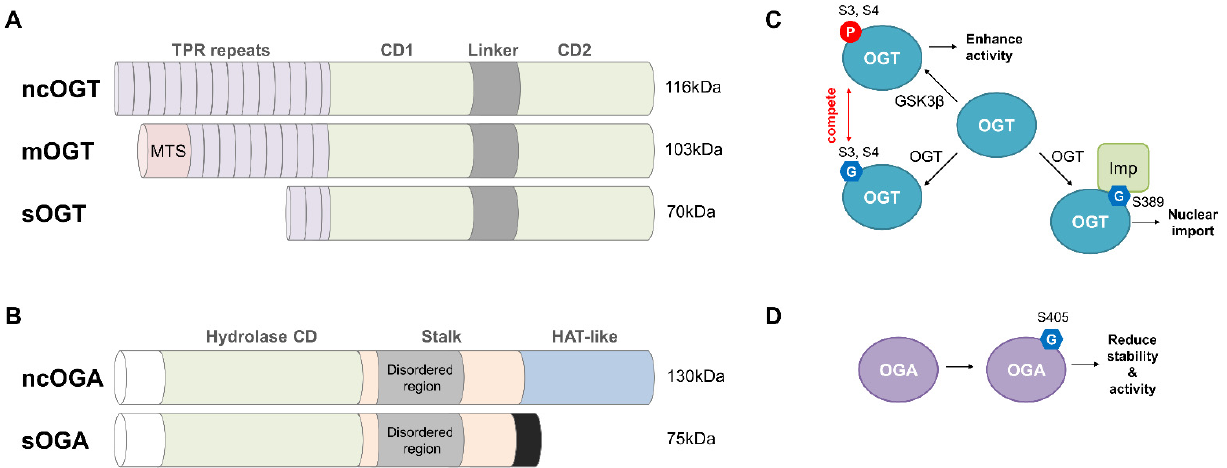
Figure 3. Exclusive enzymes directly involved in the O -GlcNAcylation cycle. ( A ) The schematic structure of hOGT isoforms. Three hOGT variants (ncOGT, mOGT, and sOGT) are derived from the OGT gene located on chromosome Xq13.1 by alternative splicing and multiple transcription start sites. These variants possess an identical catalytic domain in the C-terminal region, but they have different TPR repeats involved in substrate recognition in the N-terminal region. ncOGT (116 kDa) has 13.5 TPR repeats, mOGT (103 kDa) contains 9 TPR repeats, and sOGT possesses only 2.5 TPR repeats. Additionally, only mOGT contains a mitochondrial targeting sequence (MTS) in the N- terminal region. ( B ) The structure of human OGA (hOGA) isoforms. Two hOGA variants (ncOGA and sOGA) are produced from the MGEA5 gene located on chromosome 10q24.32. Both contain a hydrolase catalytic domain in the N-terminal region, but only ncOGA has a HAT-like domain and part of the stalk domain. ( C ) The function of OGT O -GlcNAcylation. O -GlcNAcylation at Ser389 of OGT promotes interaction with importin α 5, leading to the nuclear import of OGT. O -GlcNAcylation at Ser3 and Ser4 of OGT inhibits its activity by competing with GSK3 β -mediated phosphorylation. ( D ) The function of OGA O -GlcNAcylation. O -GlcNAcylation at Ser405 of OGA represses its stability and